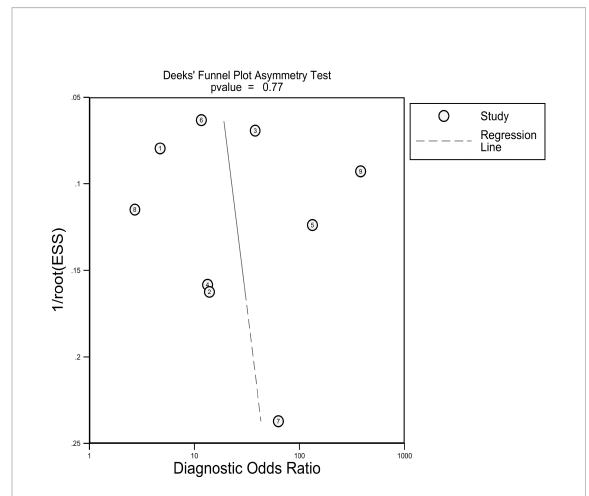
FIGURE 5 Deeks funnel plot reveals the possibility of publication bias is low with a p value of 0.77. ESS, effective sample